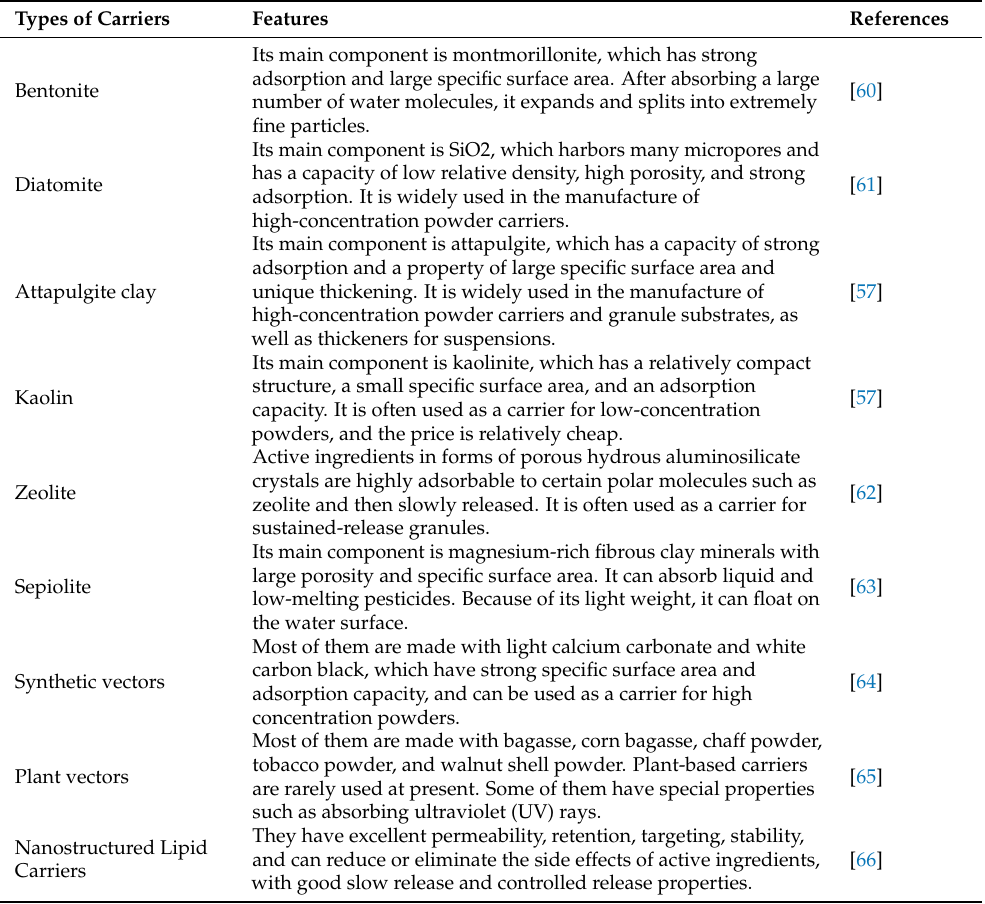
Table 3. Carriers commonly used for the production of microbial